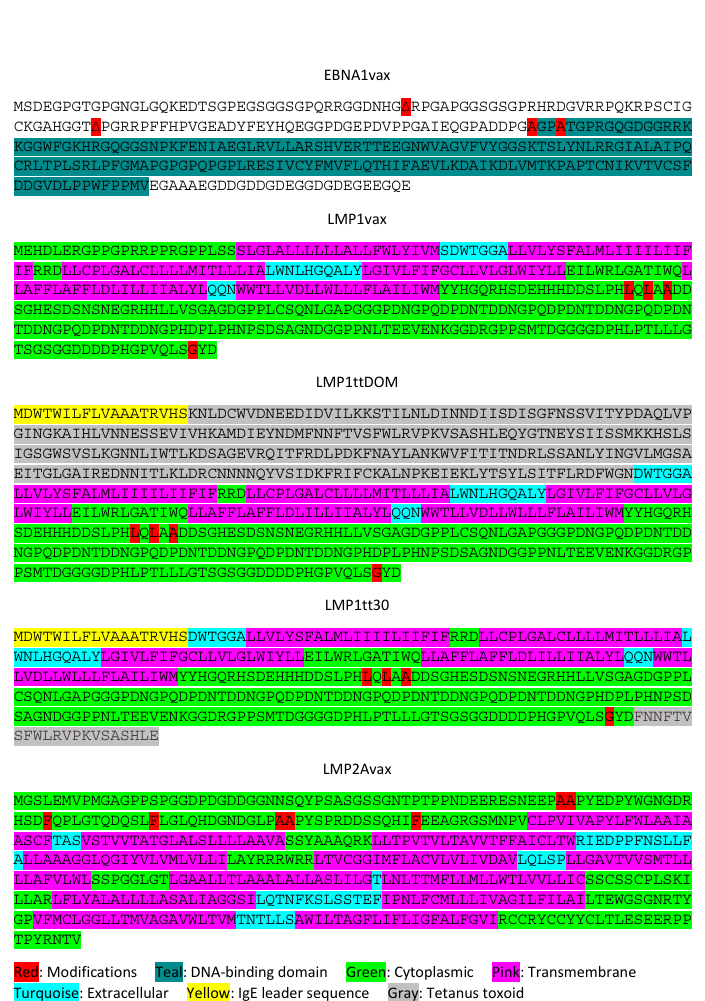
Figure A1. EBNA1vax contains deleted regions of glycine-arginine and glycine-alanine repeats marked by Δ (12 and 310 amino acid deletions) and has its DNA-binding domain highlighted. LMP1vax and LMP2Avax have their cytoplasmic, extracellular, and transmembrane regions indicated. Modifications to engineer LMP2Avax derivatives are labeled as well.